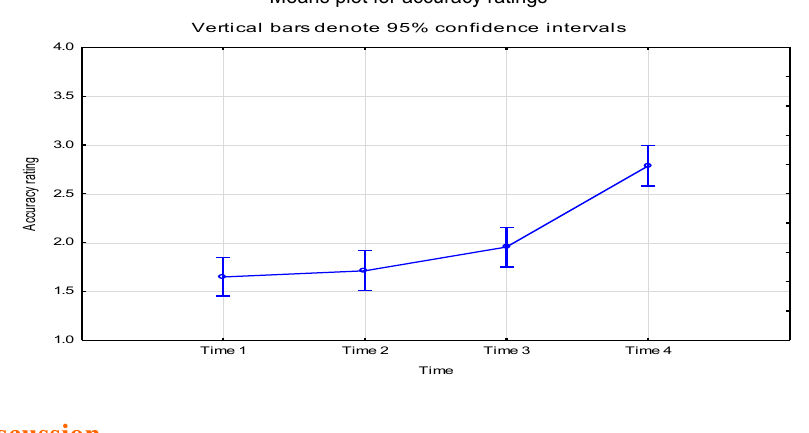
Means plot for accuracy